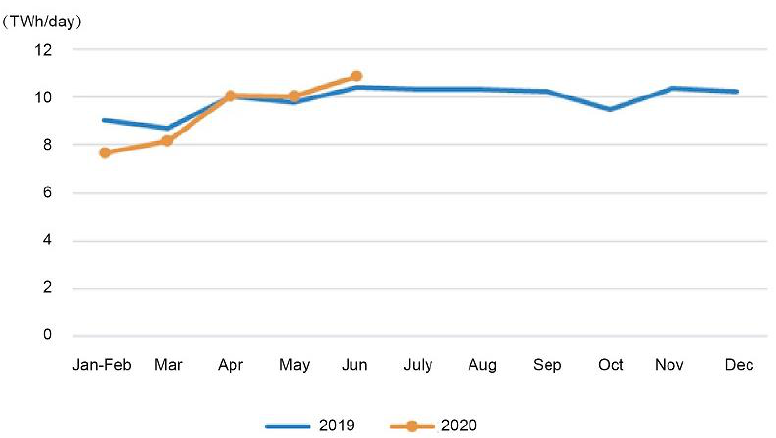
Figure 13. Manufacturing's average daily electricity consumption by month from 2019 to 2020